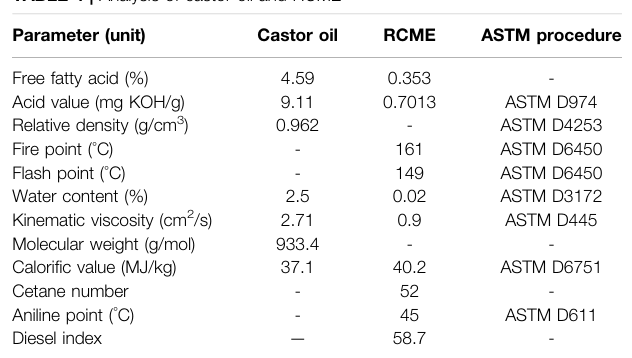
TABLE 4 | Analysis of castor oil and RCME